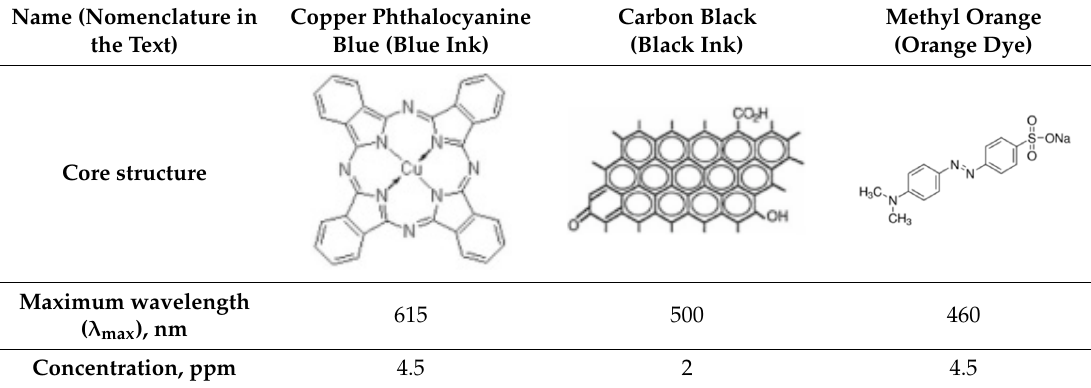
Table 2. Water-based ink and dye characterization.